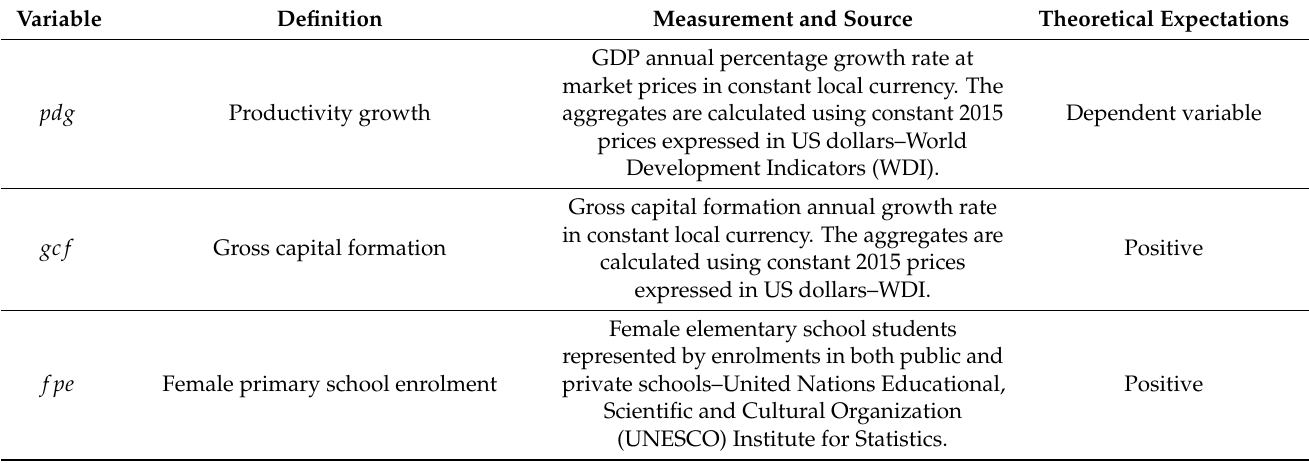
Table 1. Data Sources and